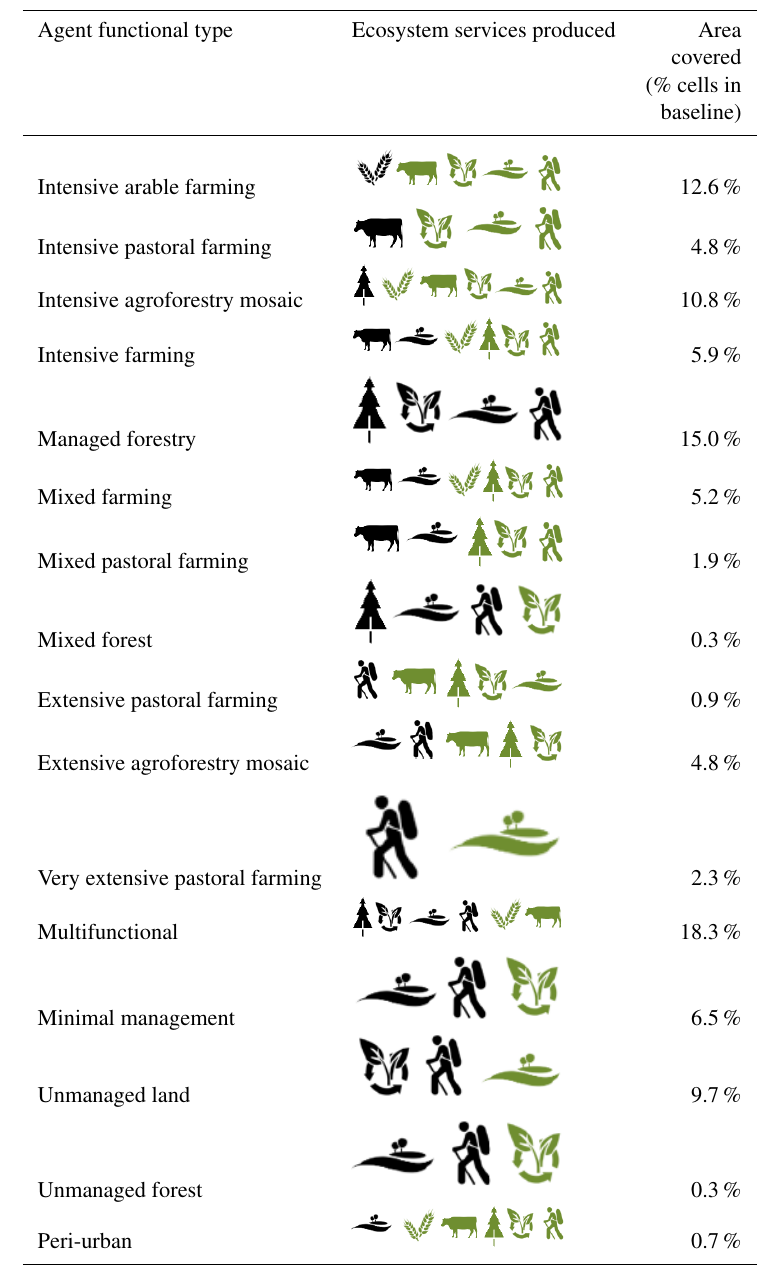
Table 1. Details of the agent functional types (AFTs) used in CRAFTY-EU. Ecosystem services are represented as follows: crops: ; . The primary ecosystem services of each AFT are those produced in quantities at least 50% of the maximum of any other AFT and are shown in black. Secondary ecosystem services are those produced in lower quantities and are shown in green. The initial distribution of these AFTs across modelled grid cells as well as the full parameterisation of capital sensitivities and production levels are described in full in Appendix A. The conceptualisation and parameterisation of AFTs allow for some variation in capital sensitivities, service production abilities and land uses within each AFT. The urban (not shown) and peri-urban AFTs are included only as placeholders for urban modelling in the IAP and are constrained to reproduce the same results here, with peri-urban also allowing for the surrounding production of other ecosystem services as